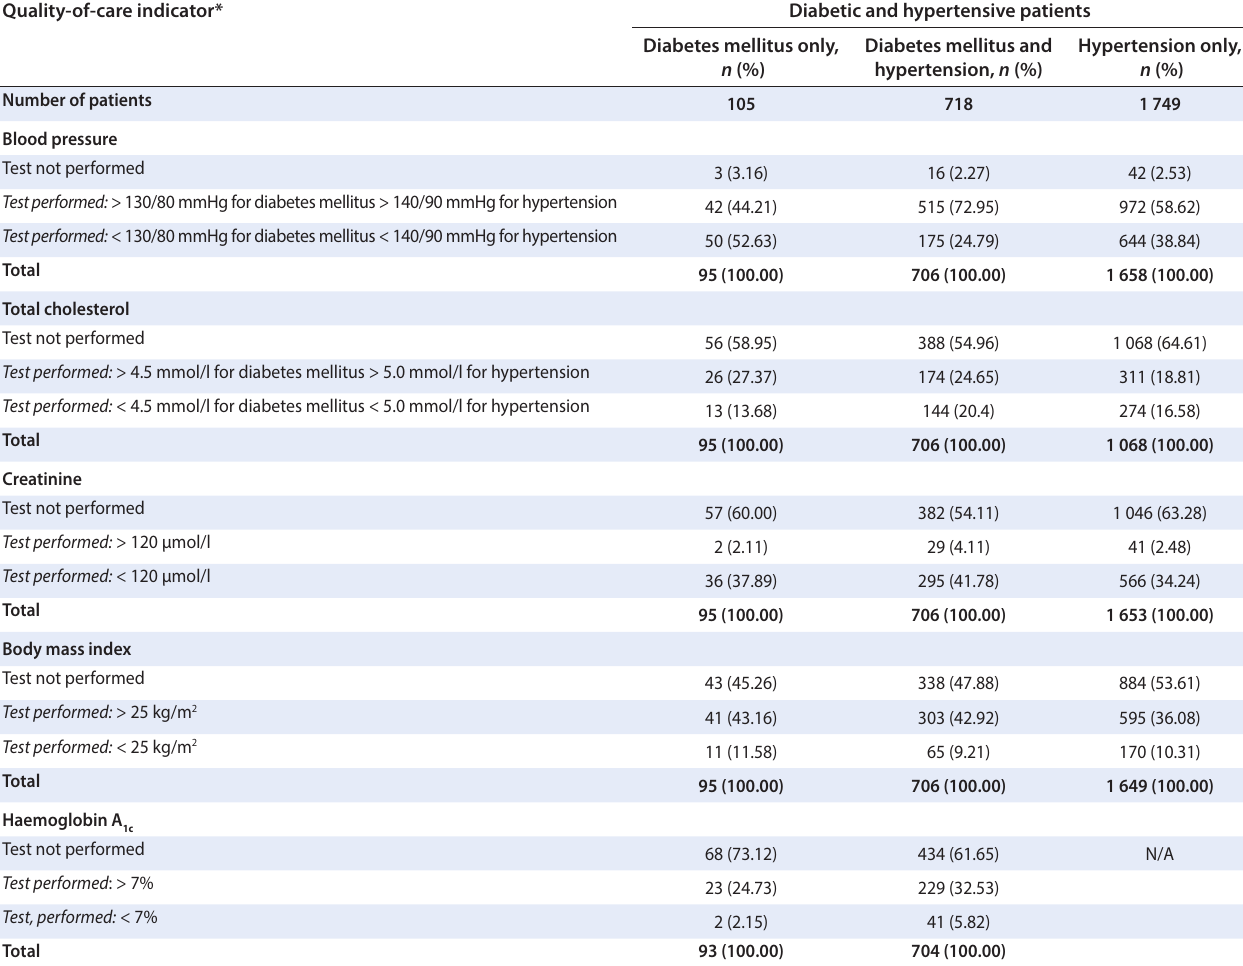
Table 3: Summary of quality-of-care indicators performed for diabetes mellitus and hypertension Quality-of-care indicator* Diabetic and hypertensive patients